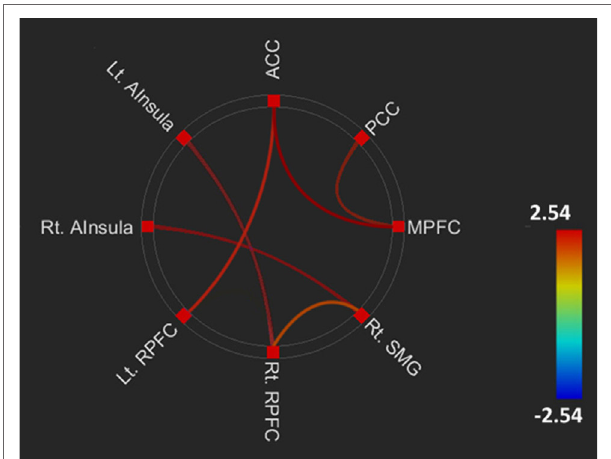
FigUre 1 | Comparing brain functional connectivity of brain areas between the SS and SL + LL allele groups. Default mode network.middle prefrontal cortex (DMN.MPFC) to posterior cingulate cortex (DMN.PCC): t = 2.42, FDRq = 0.02; left salience network.anterior insular (SAL.AInsula) to right rostral prefrontal cortex (SAL.RPFC): t = 2.42, FDRq = 0.02; right SAL. AInsula (SAL.AInsula) to right SAL supramarginal gyrus (SAL.SMG): t = 2.40, FDRq = 0.02; right SAL.SMG to right SAL.RPFC: t = 2.02, FDRq < 0.05; SAL.ACC to left SAL.RPFC: t = 2.15, p = 0.04; DMN.MPFC to anterior cingulate cortex (SAL.ACC): t = 2.61, FDRq =